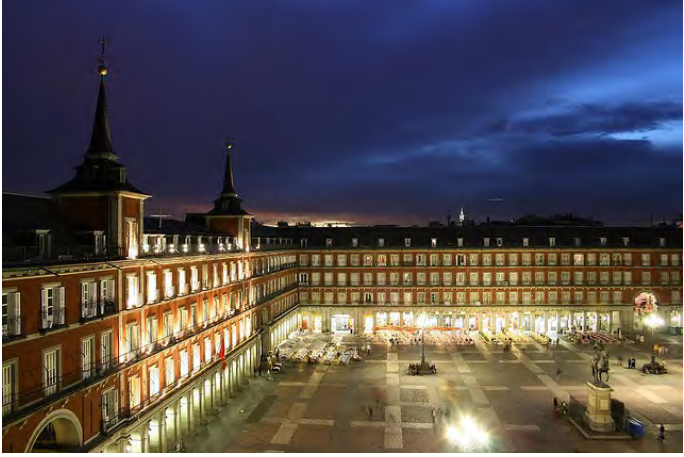
Figure 6. (Mayor Piazza in